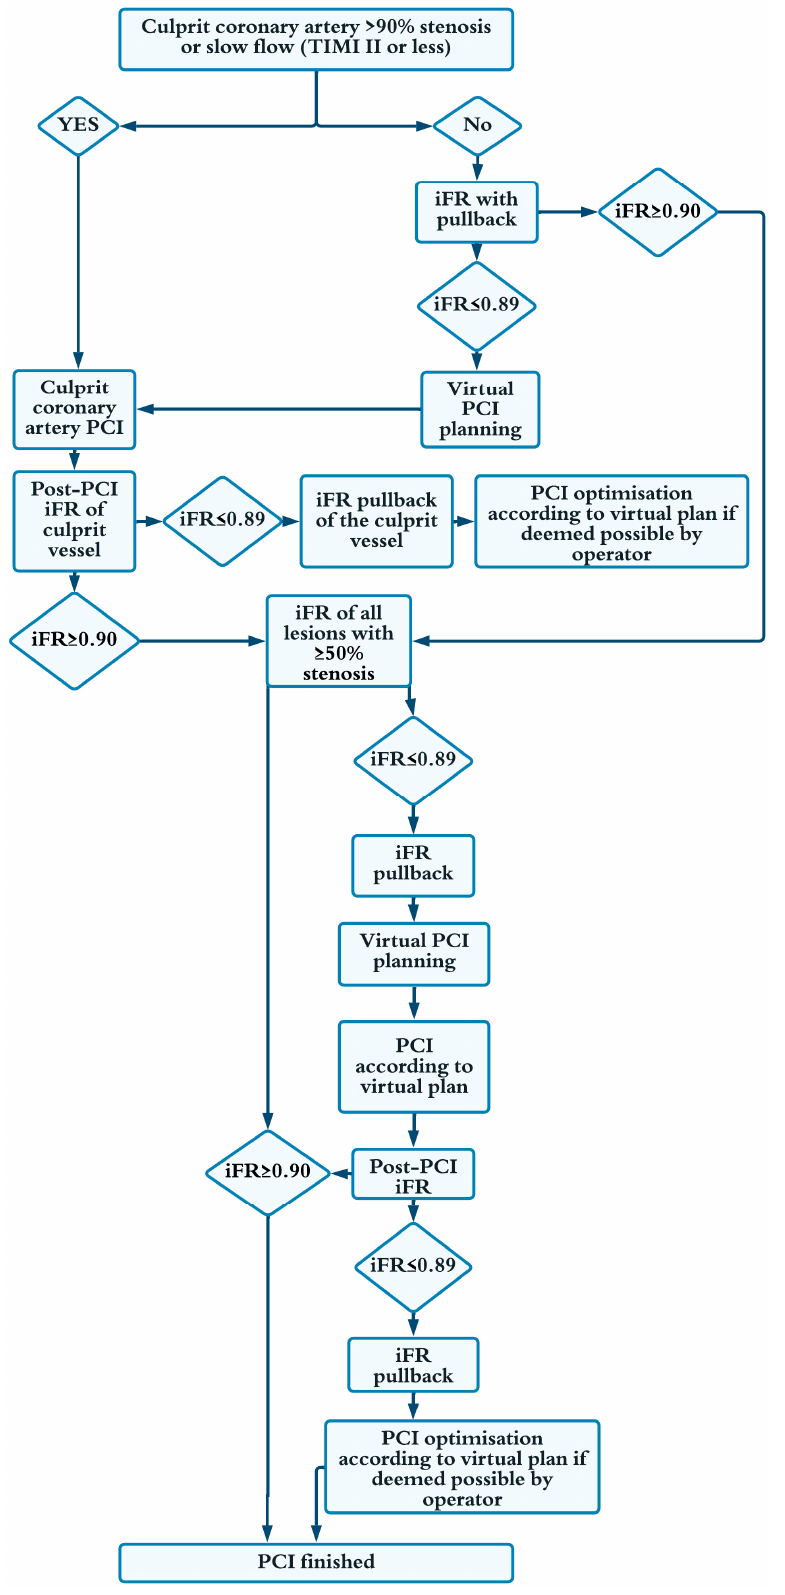
Figure 2. iFR-guided and optimised group intervention protocol. TIMI = thrombolysis in myocardial infarction flow; iFR = instantaneous wave-free ratio; PCI = percutaneous coronary intervention.